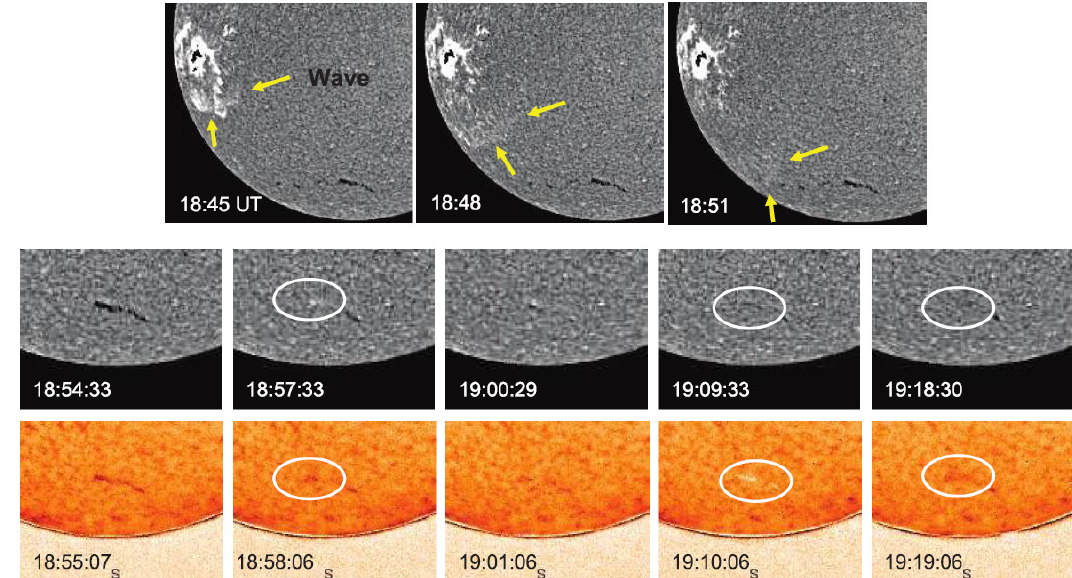
Figure 32: The Moreton wave of 2006 Dec 6 observed in H α at Mauna Loa Solar Observatory ( top ) and the initial stage of the induced filament oscillation in H α ( middle ) and He i ( bottom ). The line-of-sight motion is shifting the filament in and out of the filter passbands. Image reproduced with permission from Gilbert et al. (2008), copyright by